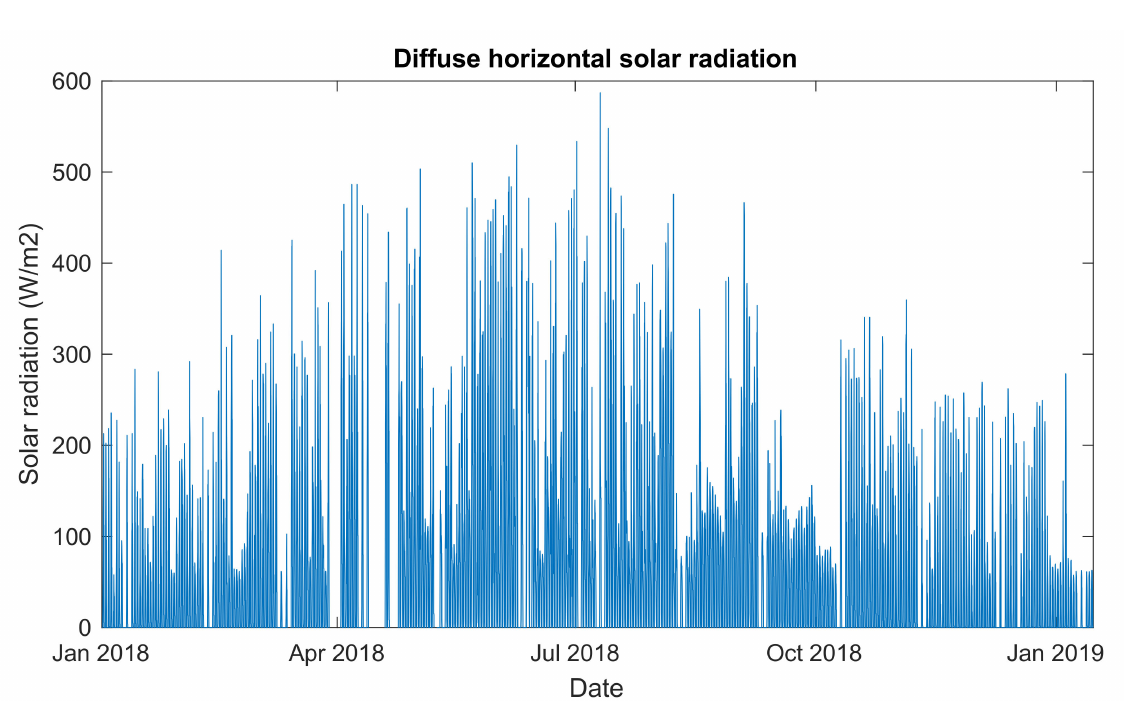
Figure A2. Direct normal solar radiation.